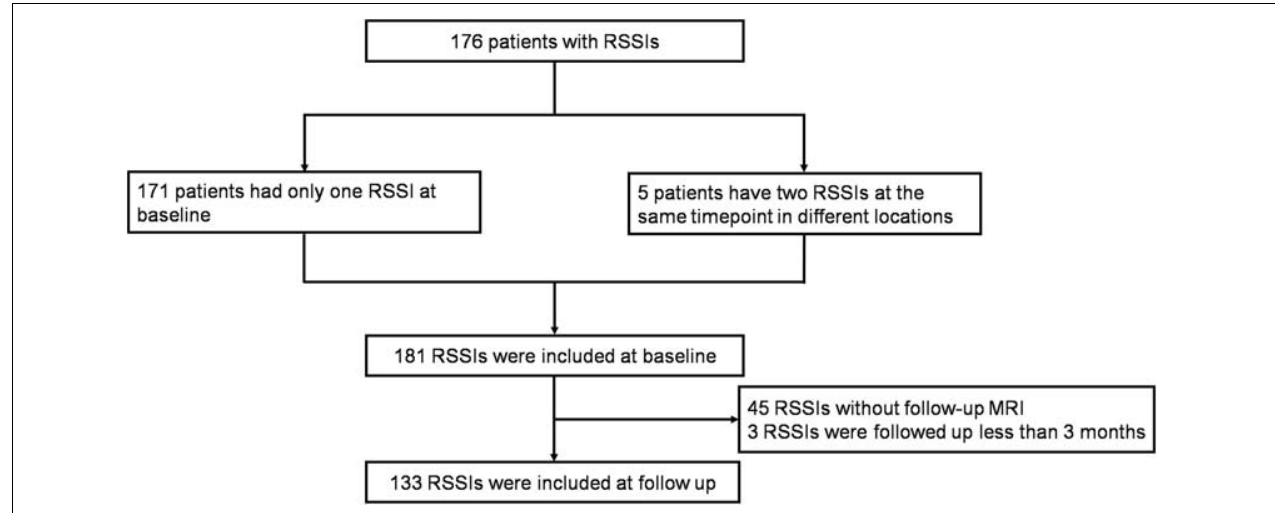
FIGURE 1 | Inclusion flow chart. One hundred seventy-six patients with RSSIs were included at baseline and RSSIs with follow-up MRI more than 3 months were included at